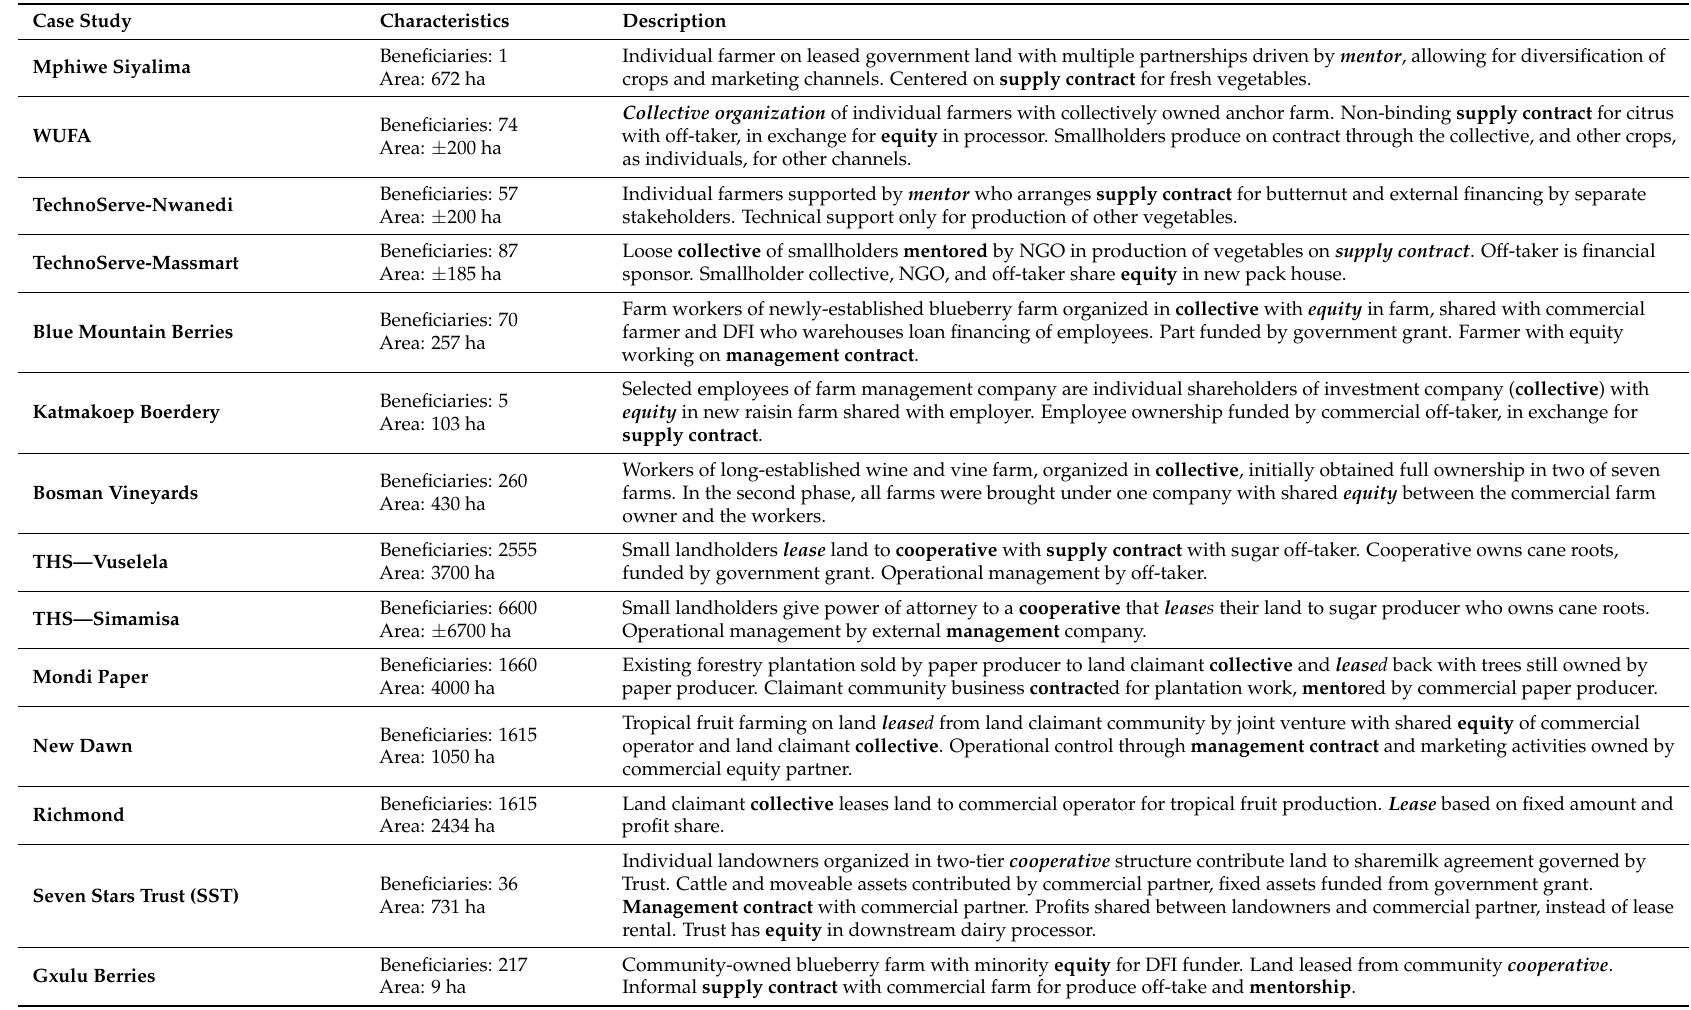
Table 1. Case Study